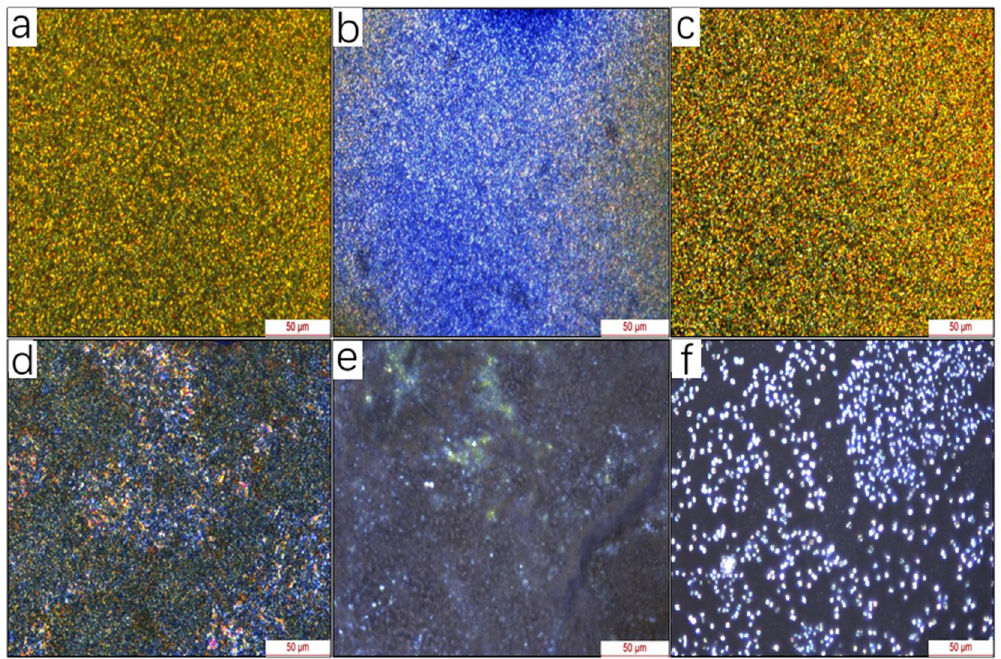
Figure 2: Polarized optical micrographs of LCP at 90°C ( a ) , LCP at 30°C ( b ) , POSS - LCP = 1 at 30°C ( c ) , POSS - LCP - 2 at 30°C ( d ) , POSS - LCP - 3 at 30°C ( e ) , and POSS at 30°C ( f )